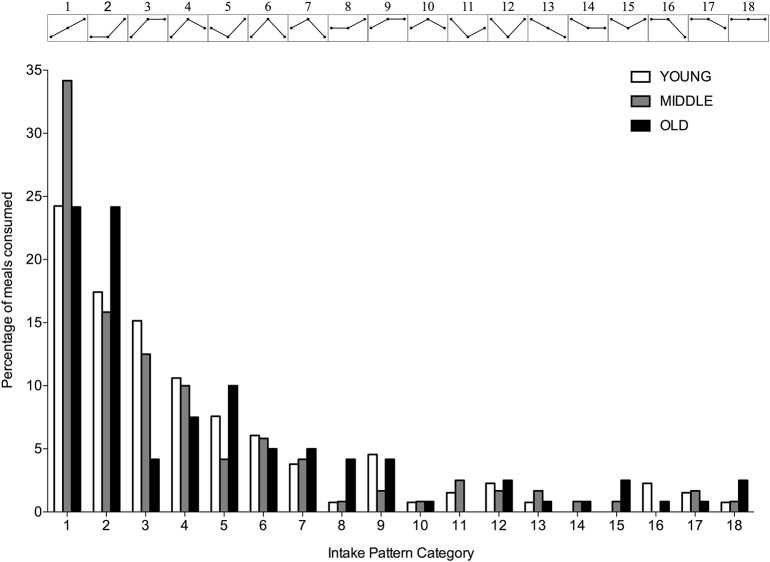
Percentage of young, middle-aged and older individuals for each observed protein intake pattern. Intake patterns are depicted above each bar and represent the relationship between protein intake at T1, T2, and T3, respectively.